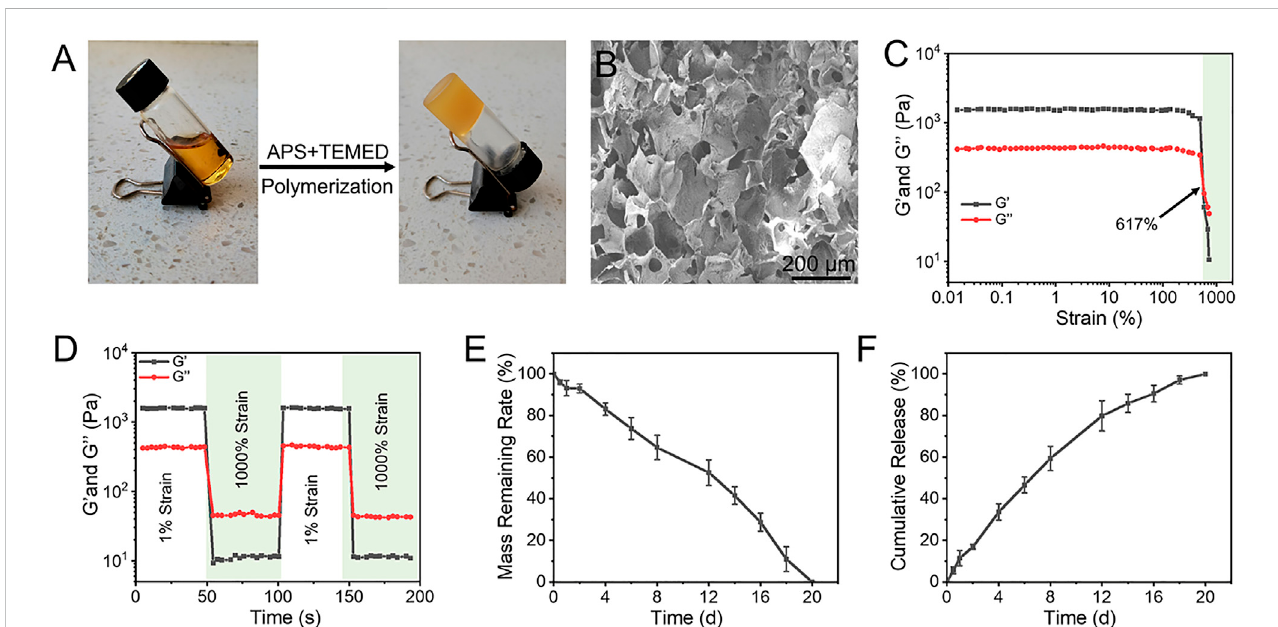
FIGURE 1 (A) The gross images of thesol – gel transition progress.The mixture ofE-A complex and AM existedin asolstate at room temperature, and it completed gelation soon after adding APS and TEMED. (B) Morphologies of hydrogel observed by SEM. (C) Strain amplitude sweep test of hydrogel with constant frequency of 10 rad s − 1 and varied strain. (D) G ′ and G ″ of hydrogel during two cycles between 1% and 1000% strain, each strain interval was kept as 50 s. (E) Degradation pro fi le of the hydrogel in PBS solution at 37 ° C. (F) Releasing pro fi les of EGCG from the hydrogel in PBS solution at 37 °